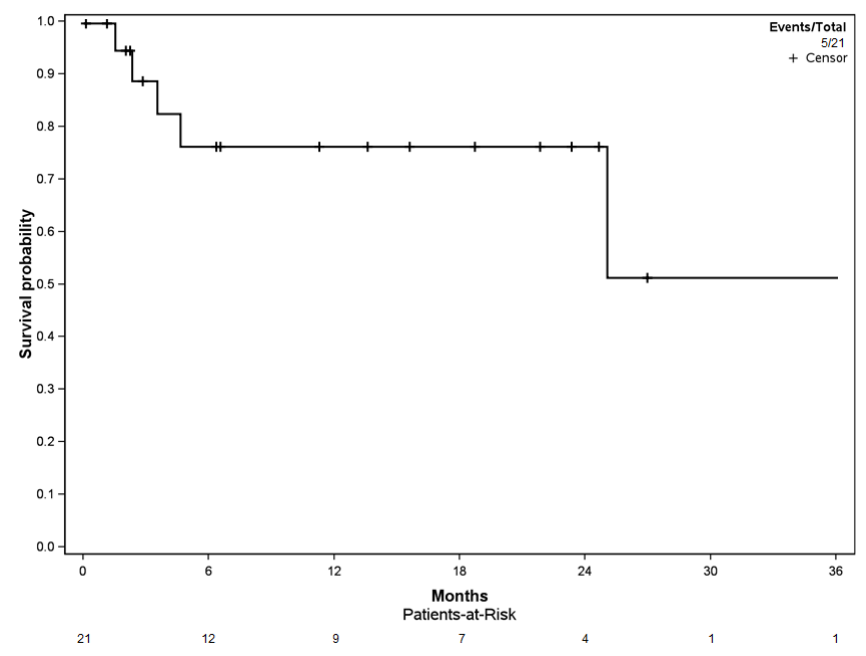
Figure 3. Functional assessment, preoperatively, at 6 and 12 months, ( A ) for Parker score and ( B ) for MSTS. *: [0.05; 0.01], **: [0.01; 0.001]. Reoperation-free survival among the cohort was 76.1% [CI 95%: 58.1–99.7] at the 6-, 12-, and 24-month follow-up (Figure 4). Four of the five reoperation events (80.0%) occurred in the first 6 months of follow-up.